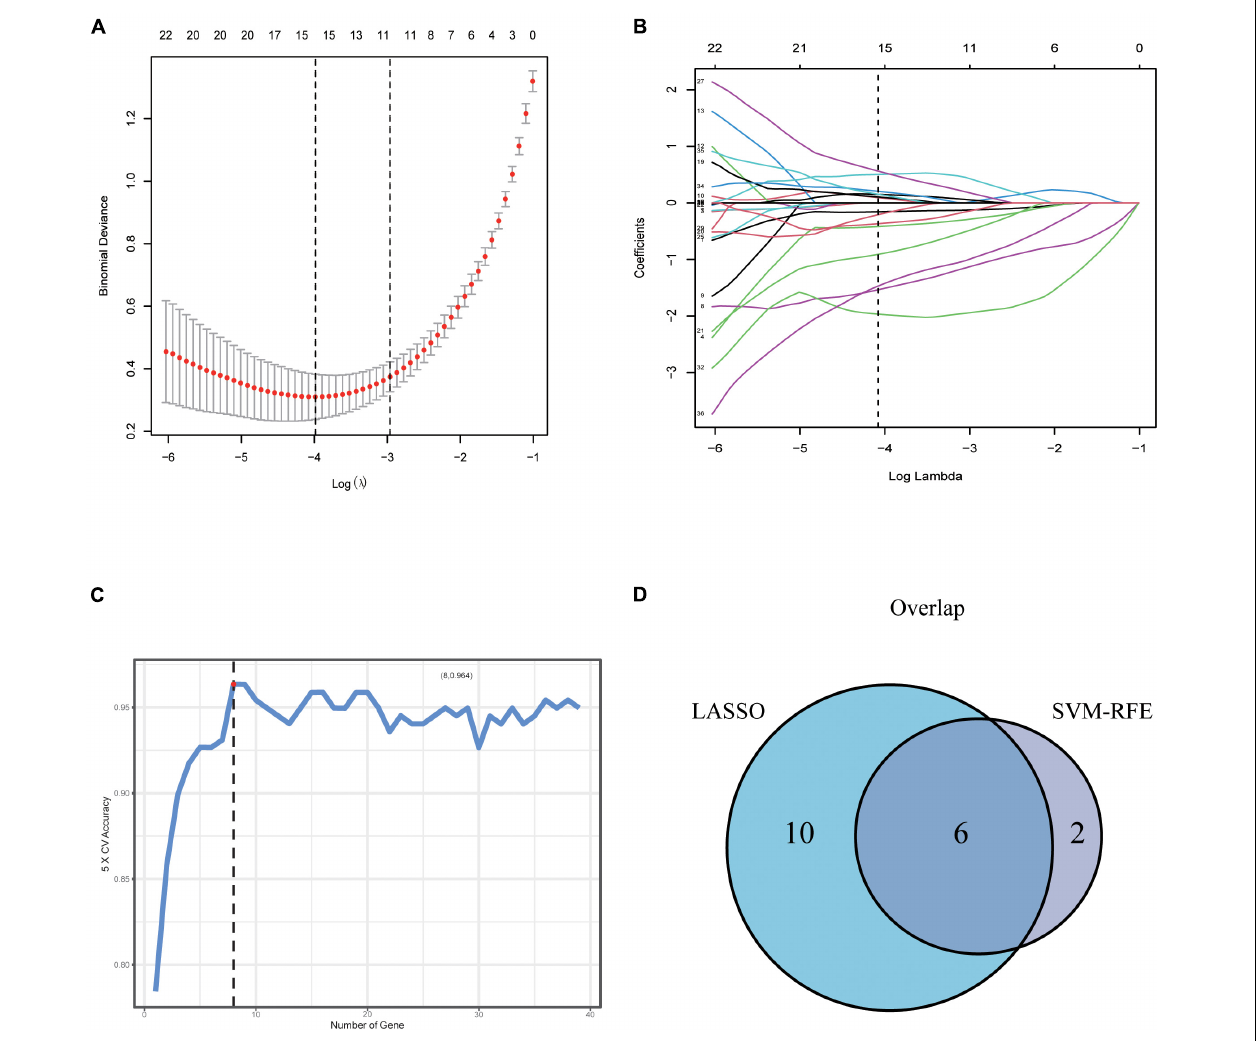
FIGURE 3 | Screening and verification of key genes. (A,B) Least absolute shrinkage and selection operator (LASSO) logistic regression algorithm to screen candidate feature genes. (C) Support vector machine recursive feature elimination (SVM-RFE) algorithm to screen candidate genes. (D) The Venn diagram shows the intersection of diagnostic markers obtained by the two